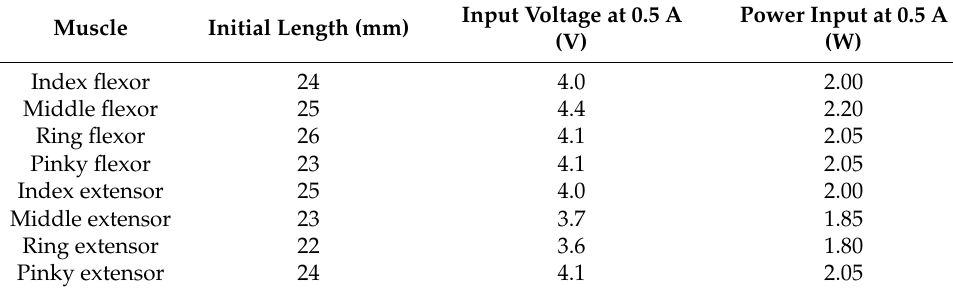
Table 2. Muscles used in the hand: length/voltages/power.